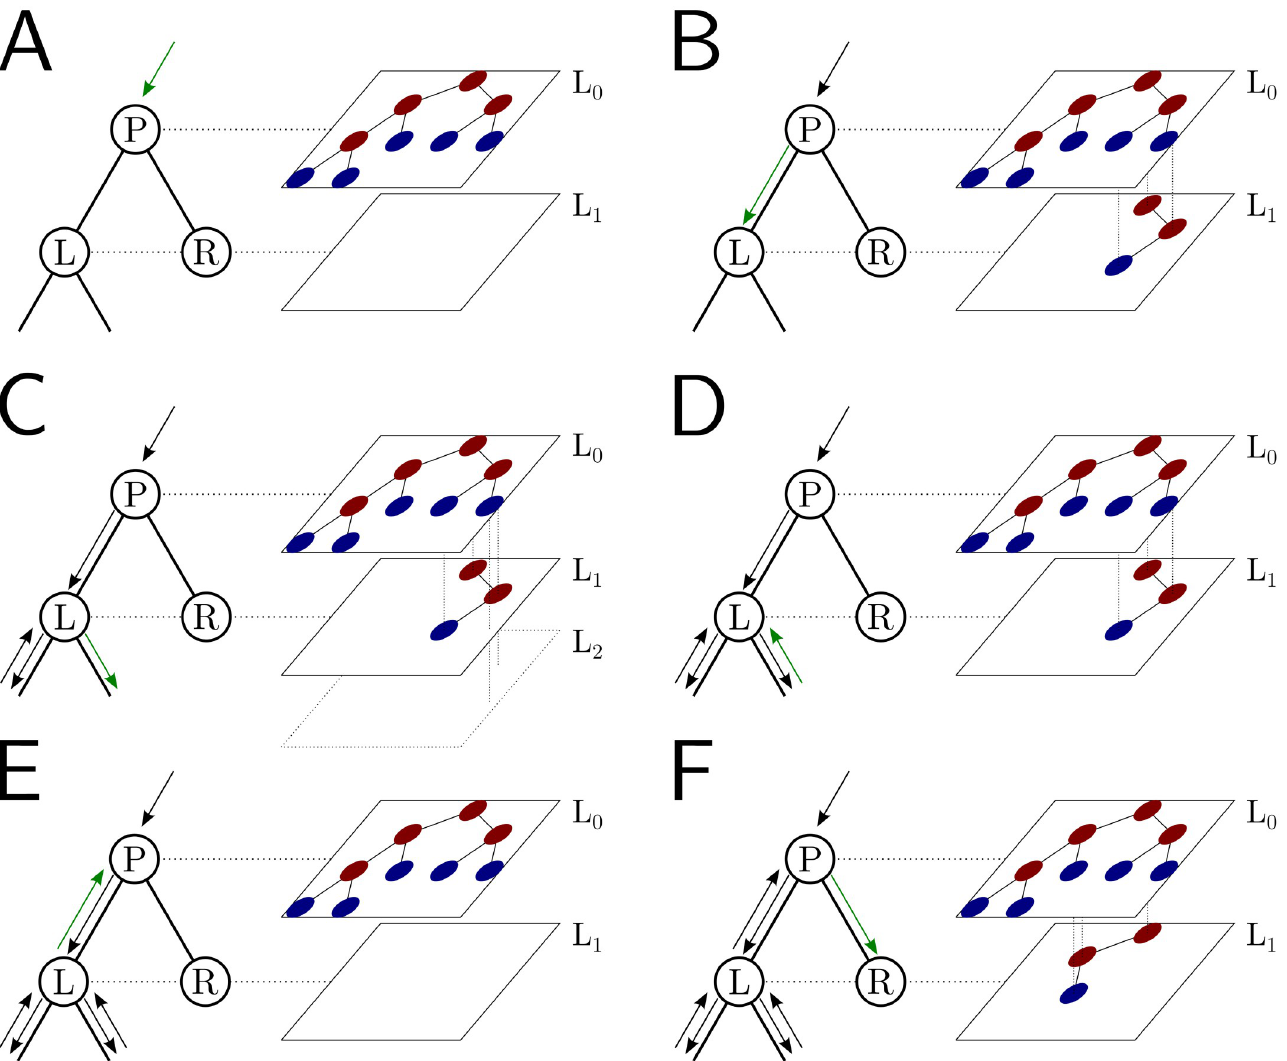
Fig 2. Example of multi-layer genome search tree and its evolution. We track the evolution of the multi-layer genome search tree starting from the genome search tree of Fig 1. Colors for the genome search tree are the same as in Fig 1 (right side of each panel). On the left side of each panel, we show an extract of the phylogenetic tree containing three nodes (“P” for parent, which in this example is the root of the phylogeny, and “L” and “R” for left and right node). “L” has further descendants, but we don’t show them here and only focus on this triplet of nodes as an example. The green arrow along the phylogenetic tree shows the current step of the preorder traversal being considered by the given panel. Black arrows show past steps. Vertical dashed lines in the multi-layer genome search tree connect nodes that represent the same portions of the genome but that are in different layers. “L0” stands for “Layer 0” and “L1” for “Layer 1”, etc. A At the phylogenetic root “P” we initialize the genome search tree for layer 0. B As we move to child “L”, a new substitution is sampled (as in Fig 1) and 3 corresponding genome nodes are created in layer 1. These nodes correspond to the nodes in the original genome search tree whose rate is affected by the new mutation. C As we traverse the subtree of the descendants of L, new nodes and mutations might be added in the layers below. D We are finished traversing the subtree of the descendants of L, and we return to L, at which point all nodes in layer below 1 have either been removed or have become irrelevant. E We return to P, at which point the genome search tree nodes previously added layer 1 are also ignored or deleted. F We move from P to R, and in doing so new mutation events might be sampled and the corresponding genome nodes might be added to layer 1 (new genome search tree nodes corresponding to 1 new substitution are shown in the new layer